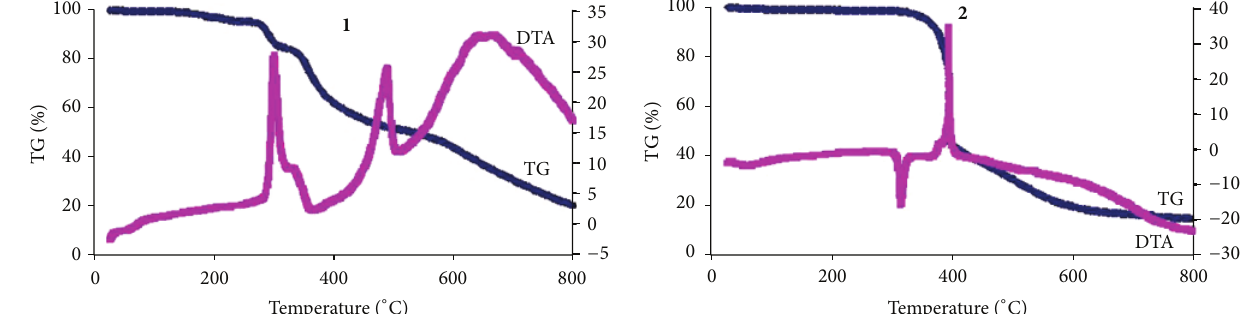
Figure 5: Thermogravimetric curves (TG and DTA) for complexes 1 - 2 .